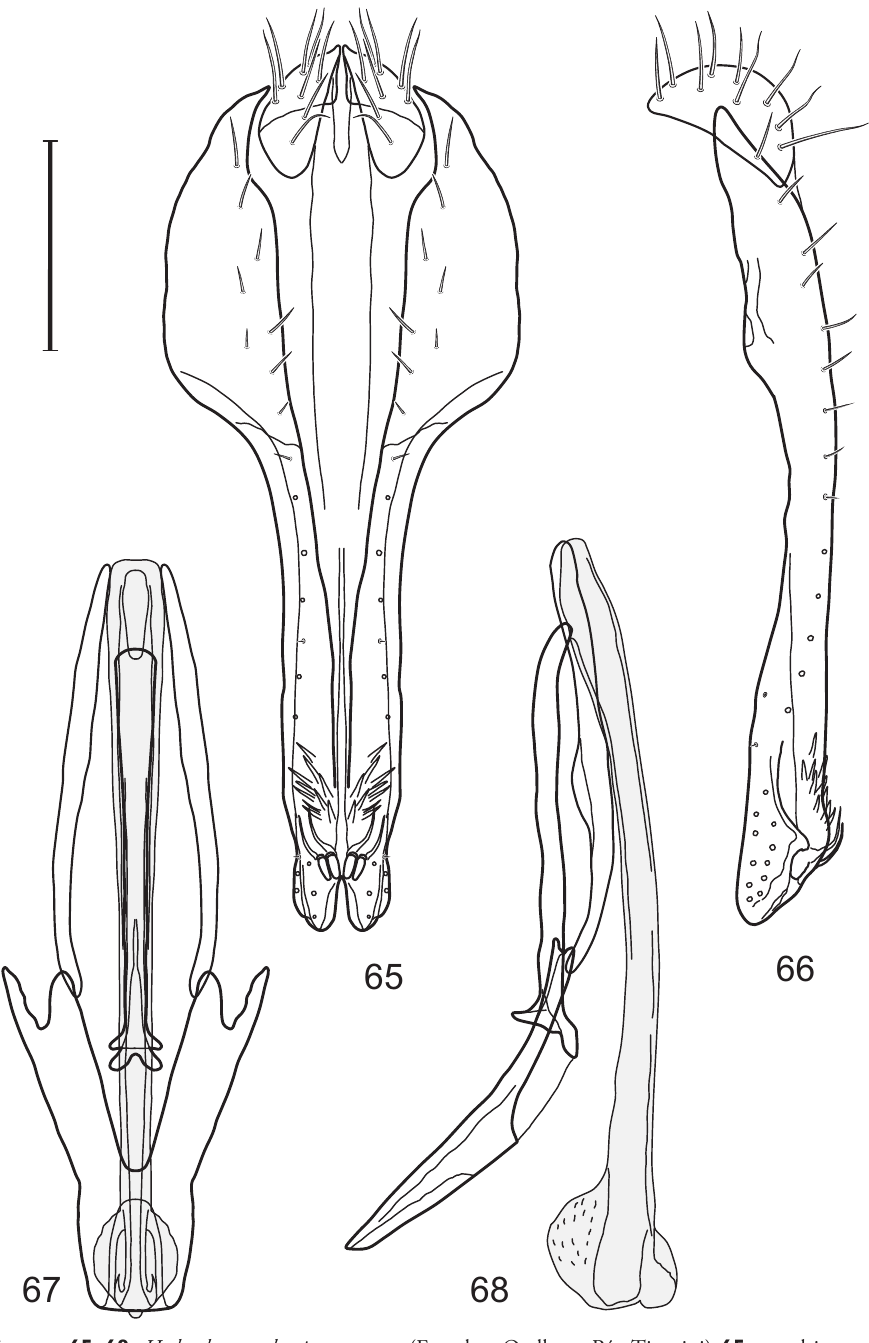
Figures 65–68. Hydrochasma denticum sp. n. (Ecuador. Orellana: Río Tiputini) 65 epandrium and cerci, posterior view 66 same, lateral view 67 internal structures of male terminalia (aedeagus [shaded], phallapodeme, gonite, hypandrium), ventral view 68 same, lateral view. Scale bar = 0.1